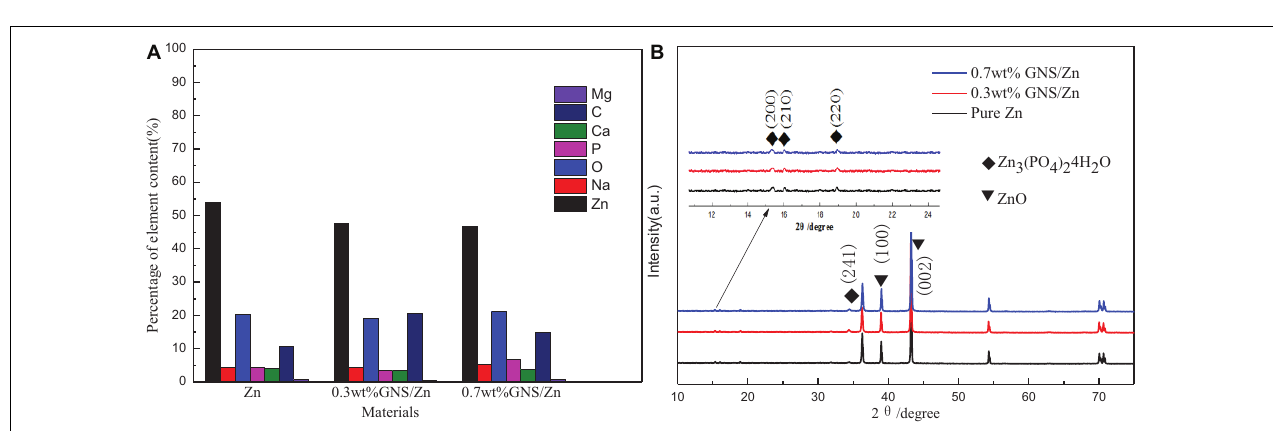
FIGURE 13 | (A) The cross-sectional view after immersion in SBF solution corresponding to the percentage distribution of EDS element content, (B) XRD pattern of the corrosion products of composite materials.